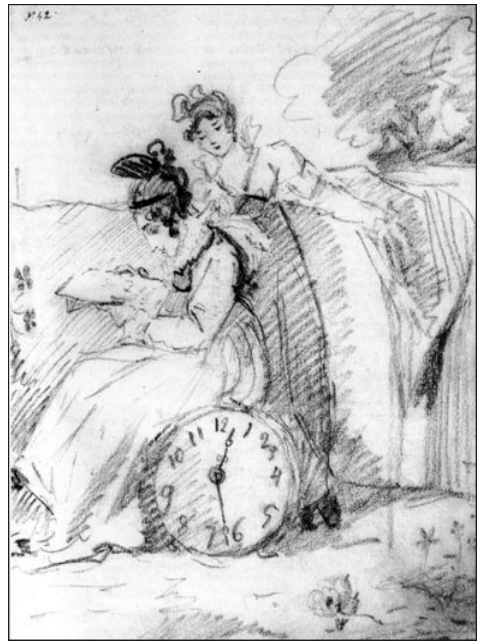
Figure 46. Konstantin Batiushkov. Sofia Ponomaryova with her Dame de Compagnie (?) , 1818 (?). Figure46. KonstantinBatiushkov. SofiaPonomaryovawithherDamedeCompagnie(?) , 1818(?). Russian Russian State Archives of Literature and Art, Moscow. State Archives of Literature and Art,